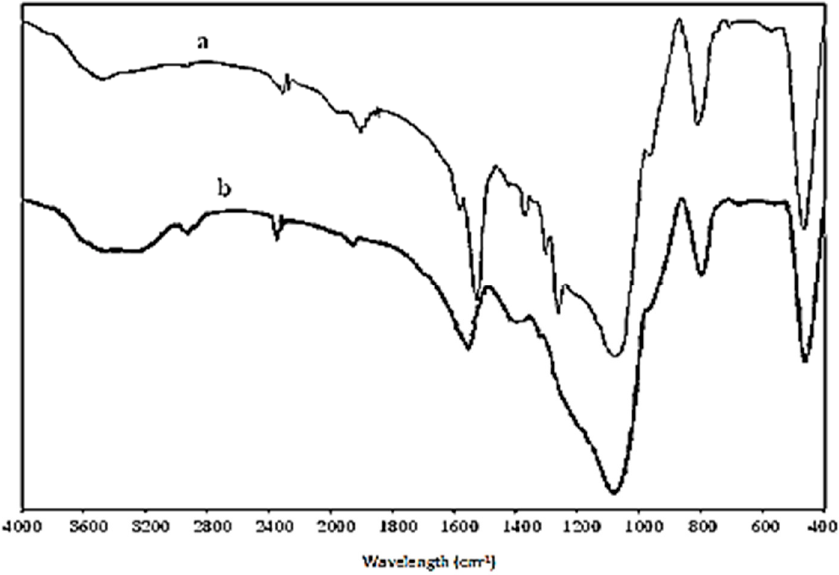
Figure 1. The FT ‐ IR spectra of L2@SBA ‐ 15 ( a ) and Cu ‐ L@SBA ‐ 15 ( b ) .